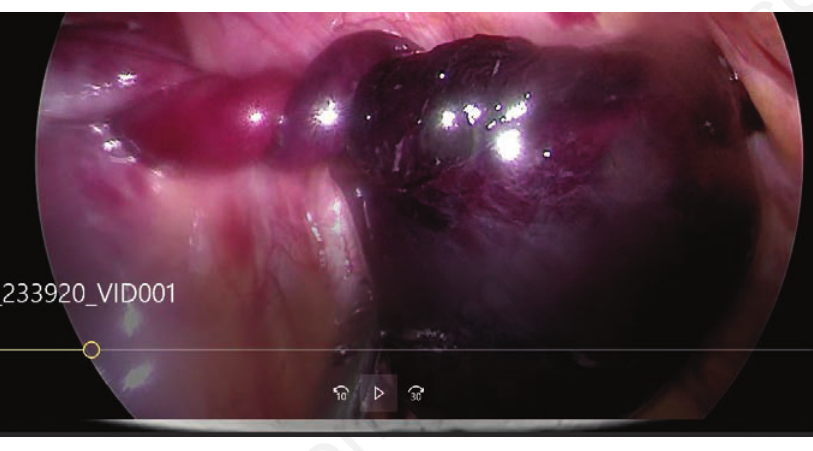
Figure 2. Laparoscopic exploration of pelvic organs.